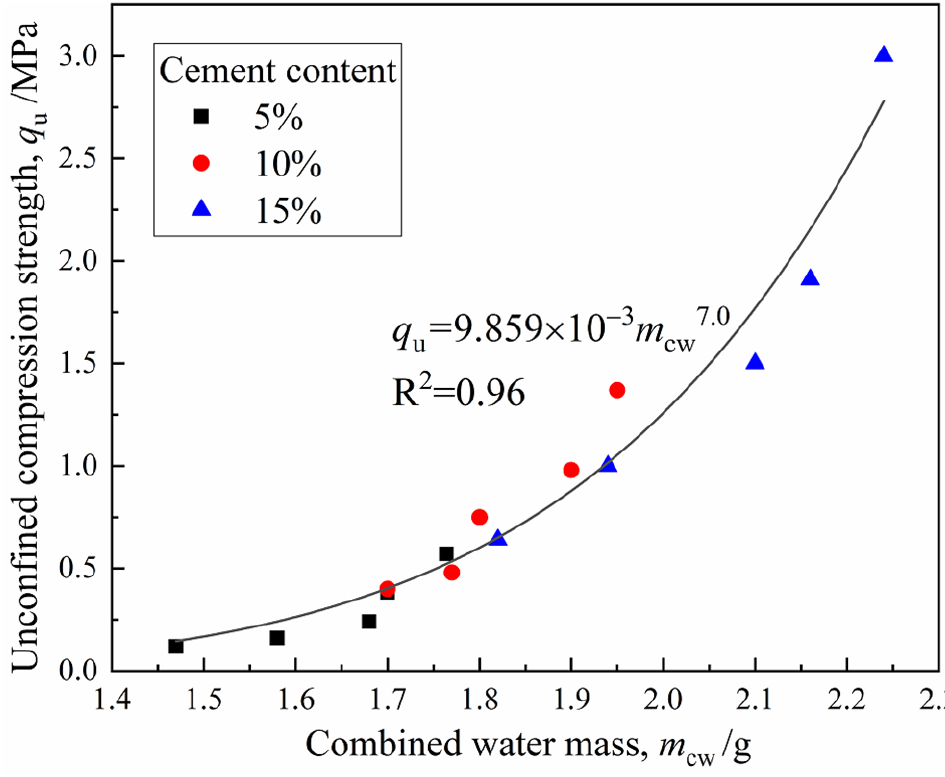
Figure 16. Relationship between q u and m cw.